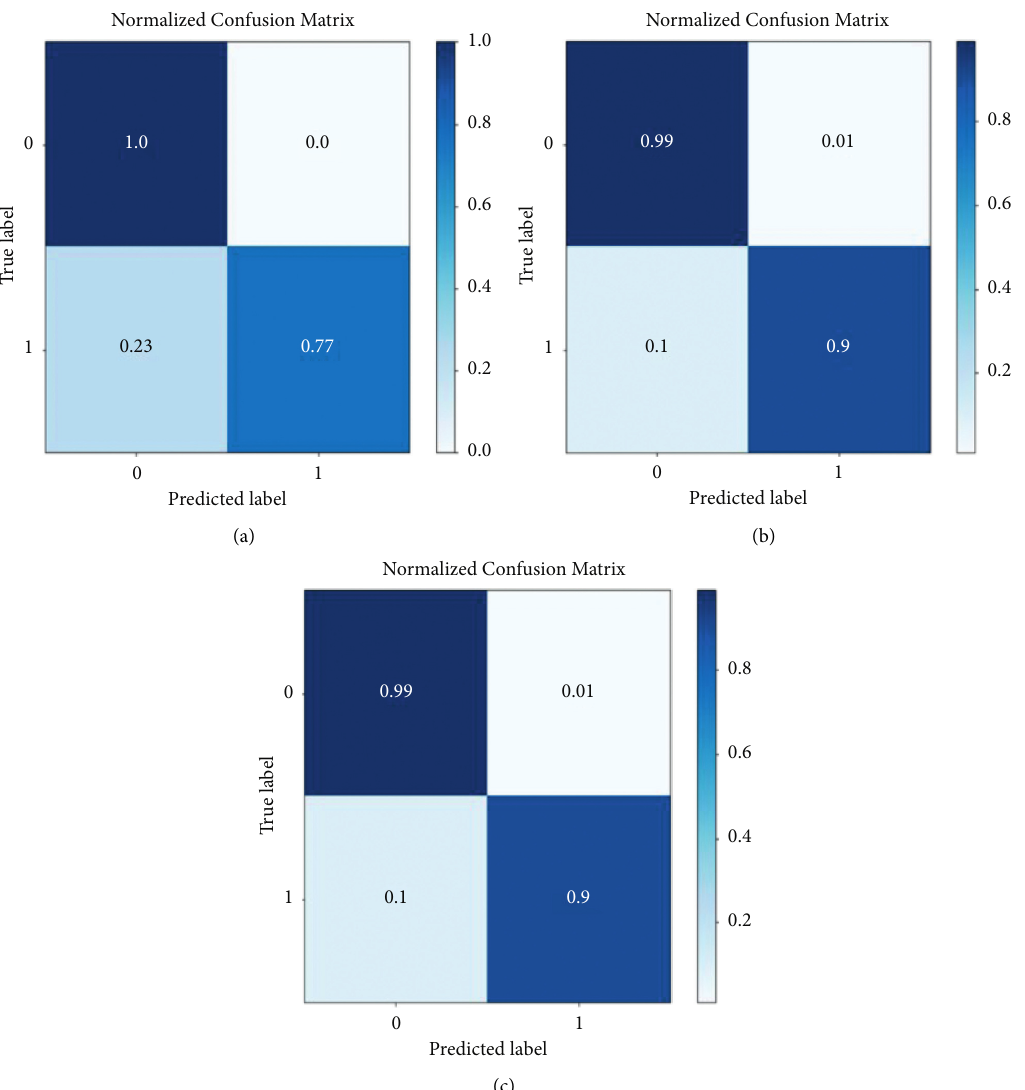
Figure 3: Normalized confusion matrix for random forest, neural network, and ensemble models.